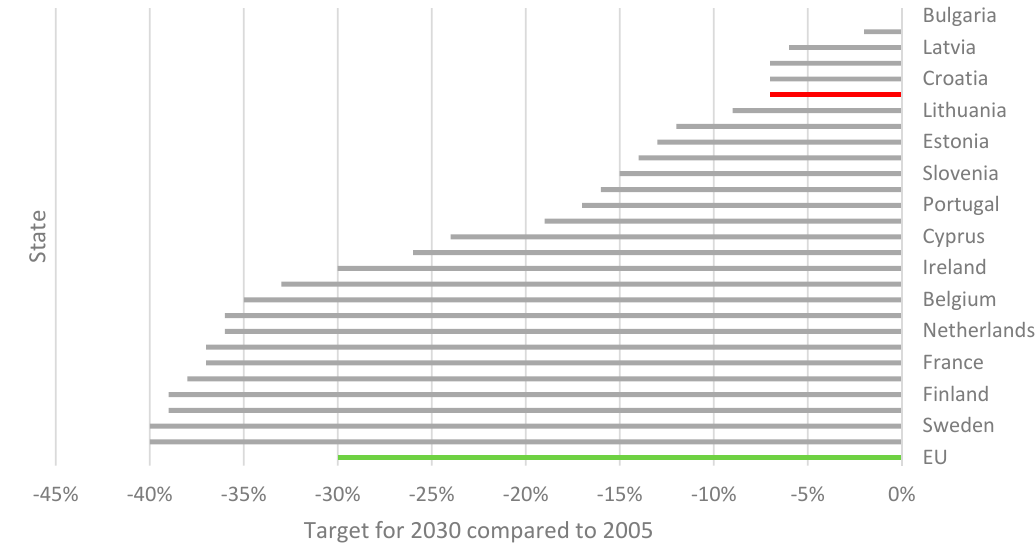
Figure 2. Reduction goals of EU countries in the non-ETS (Emissions Trading System) area in the perspective of 2030, according to ESR Regulation [14], source: own study based on data [15].